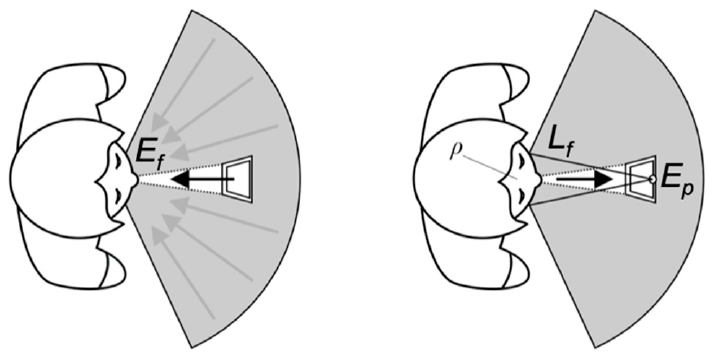
Figure 1. Illuminance measurement geometry with mobile devices. The face illuminance ( E f ) is affected by light from the central and surrounding peripheral visual field ( left ). Part of the light is reflected (depending on face reflectance, ρ ), and the resulting luminance of the face ( L f ) determines the illuminance ( E p ) present at the camera CCD plane ( right ).